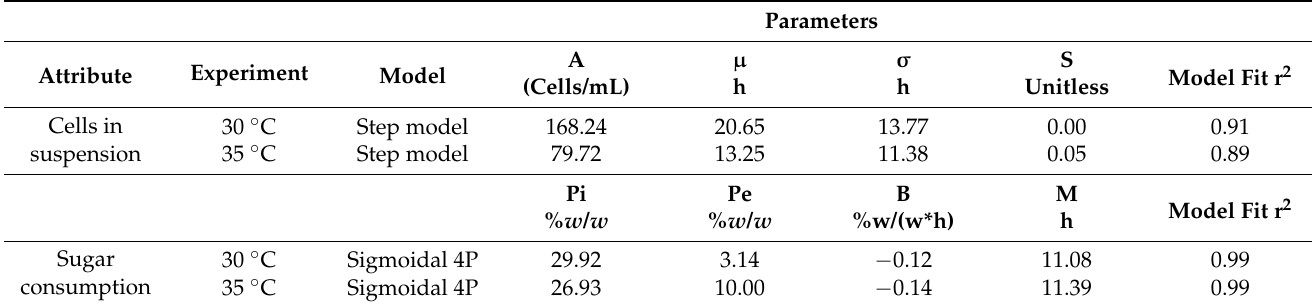
Table 1. Step and logistic model parameters.